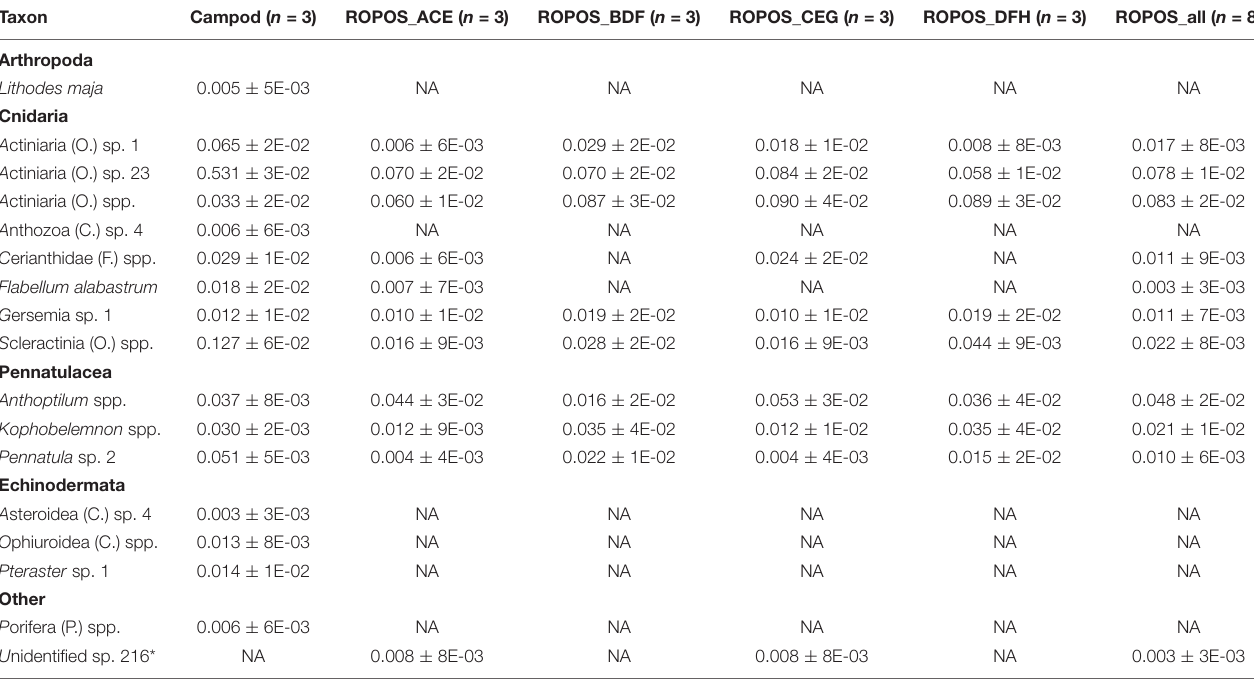
TABLE 4 | Abundance of individuals or colonies m − 2 (mean ± SE) at station LC5 in the Laurentian Channel MPA averaged across transect and then averaged across each of six sampling designs. Taxon Campod ( n =